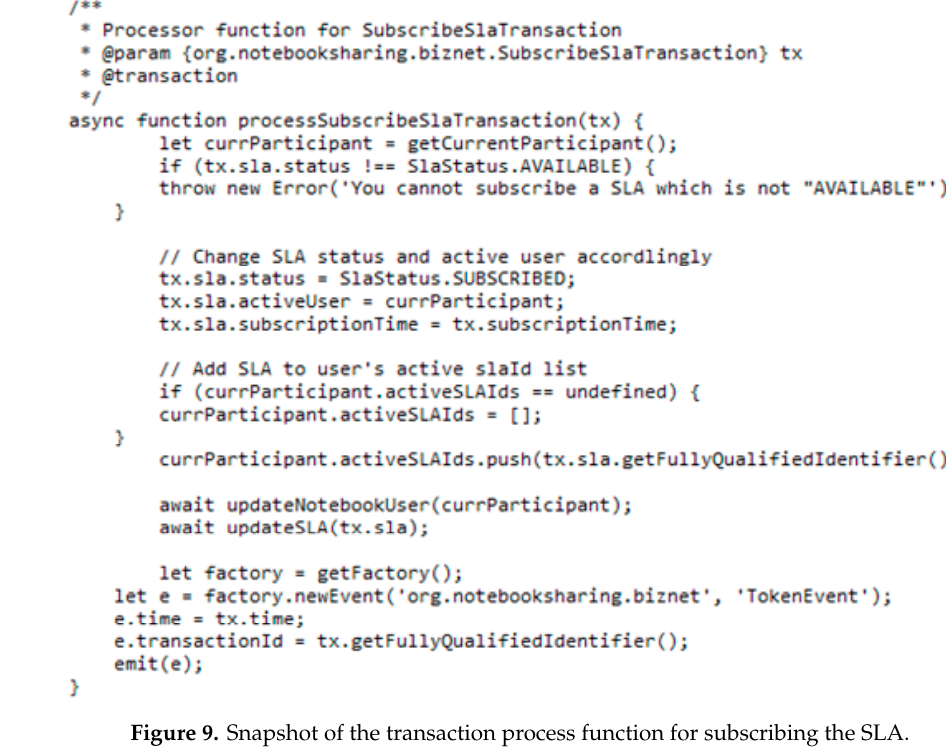
Figure 9. Snapshot of the transaction process function for subscribing the SLA.